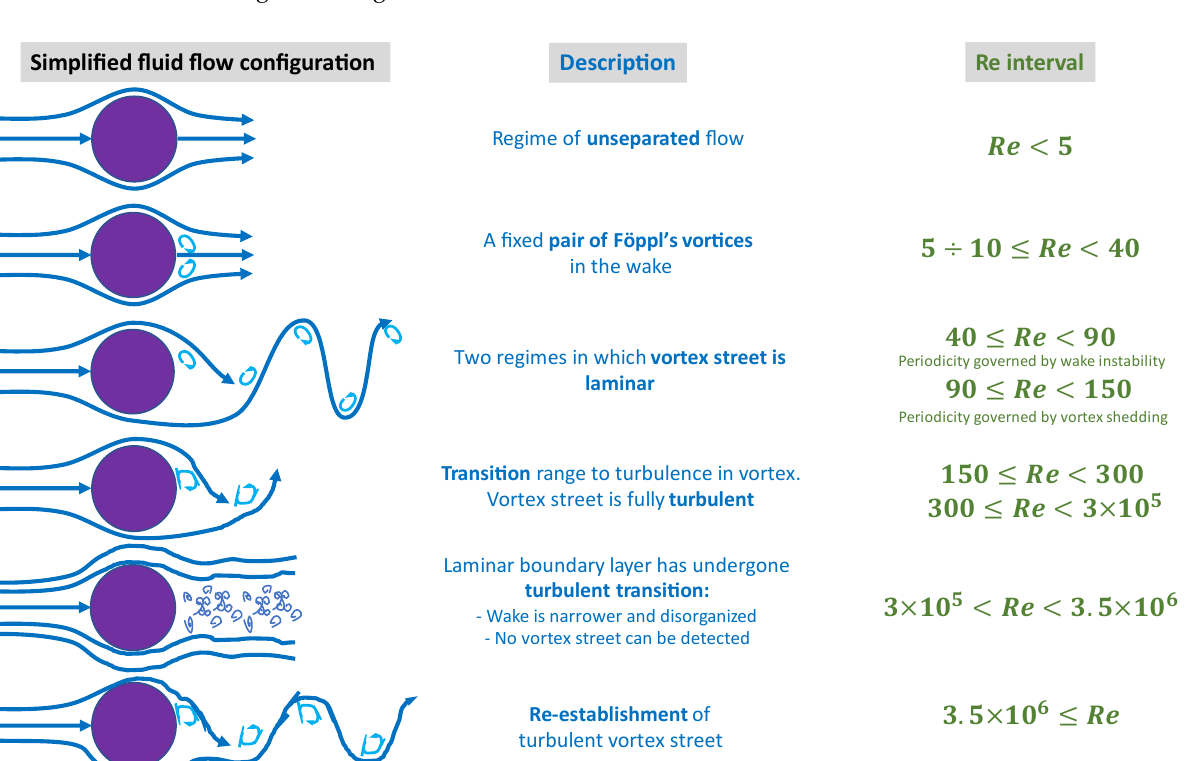
Figure 1. Variation of the von Karman vortex streets as a function of the Reynolds number Adapted from [12].